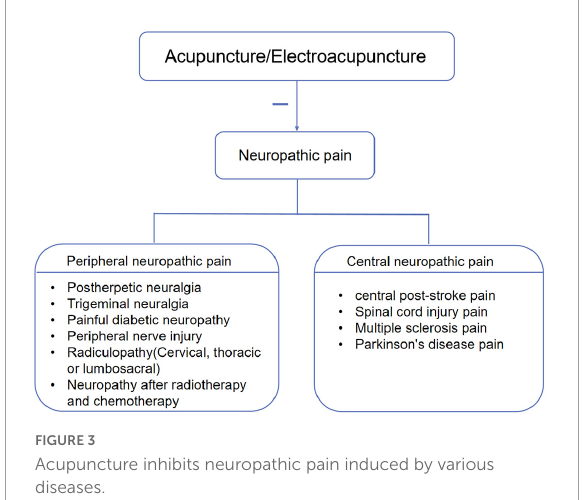
FIGURE3 Acupuncture inhibits neuropathic pain induced by various